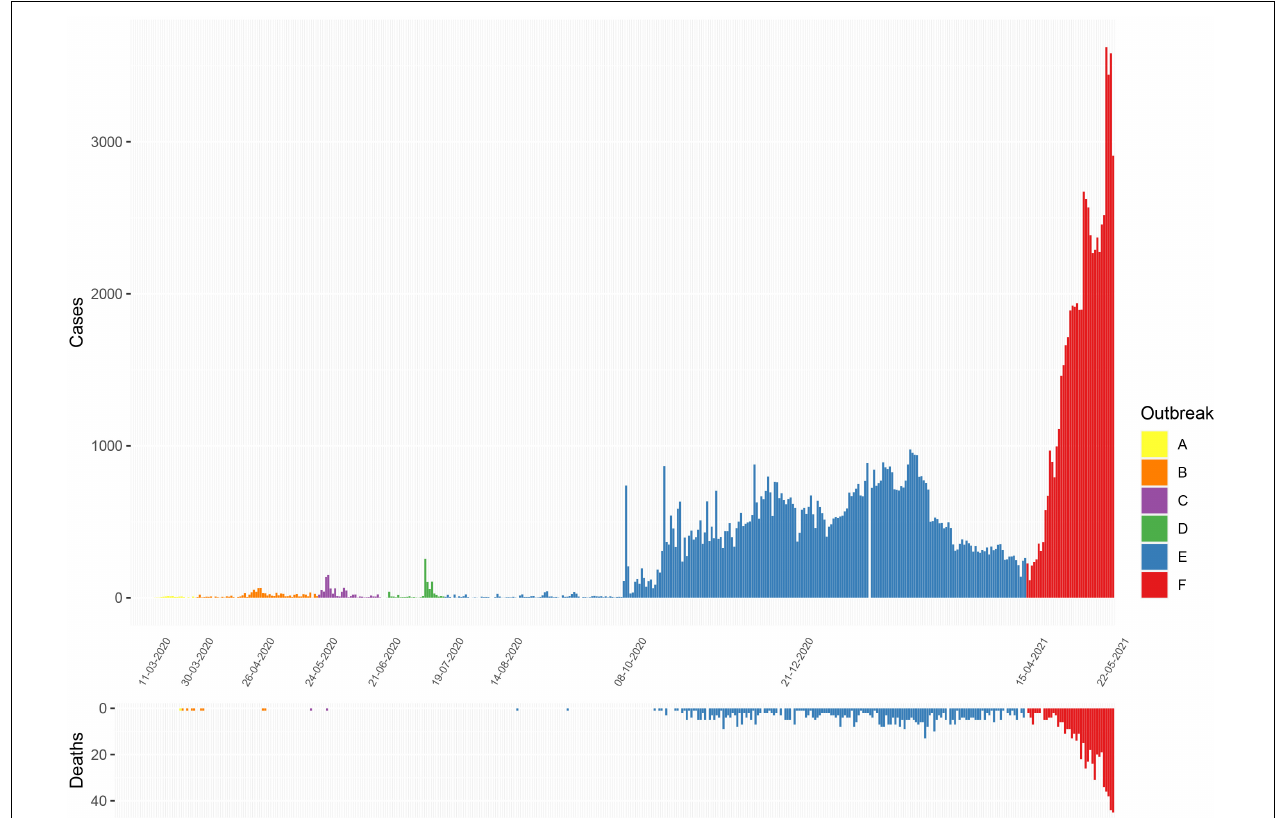
FIGURE 1 | Epidemiological curves of COVID-19 cases and deaths reported in Sri Lanka from March 11, 2020 to May 22, 2021. (Data from Epidemiology Unit, Ministry of Health, Sri Lanka) (Ministry of Health, 2020a). A, initial outbreak from overseas returned; B, closed outbreak in a the Colombo Municipality area; C, returnees from Middle East; D, outbreak at the drug rehabilitation centre; E, the large outbreak that initially began in a clothing factory; and F, the current ongoing outbreak.